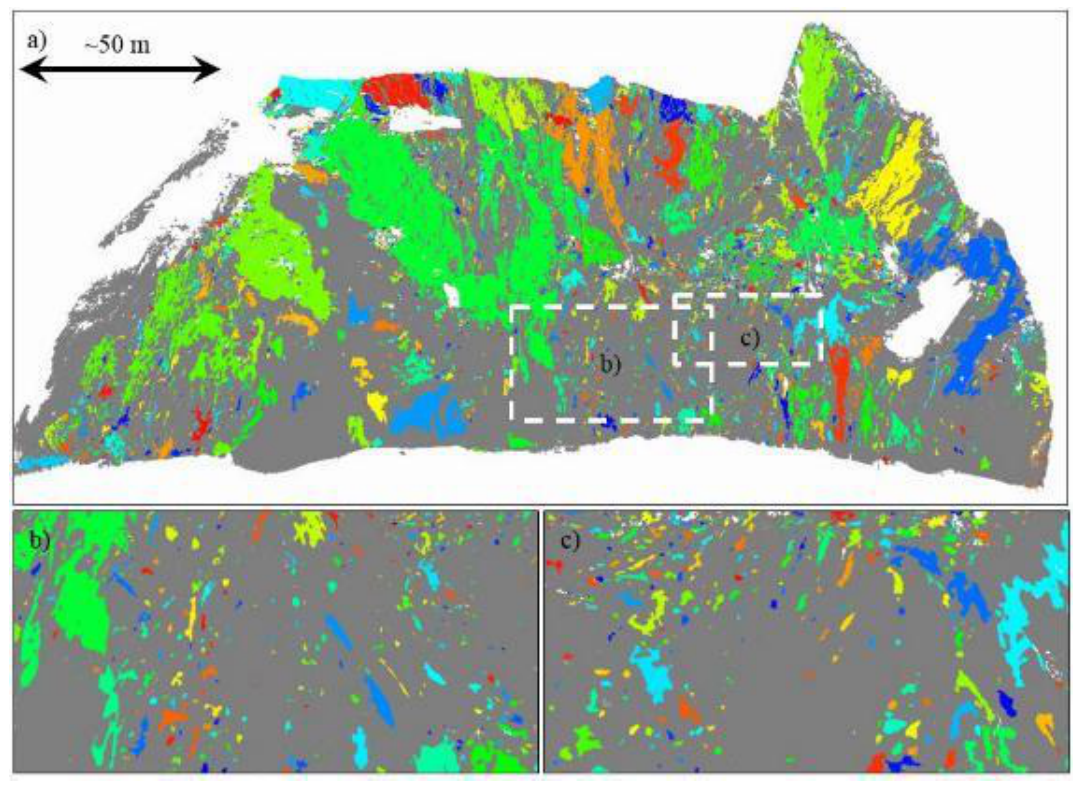
Figure 19. Map of individual failure clusters between the 2013 and 2014 surveys at Site C (0.10 m resolution). These clusters are colored using the same scheme described in Figure 9 where grey indicates no significant erosion and white represents holes.